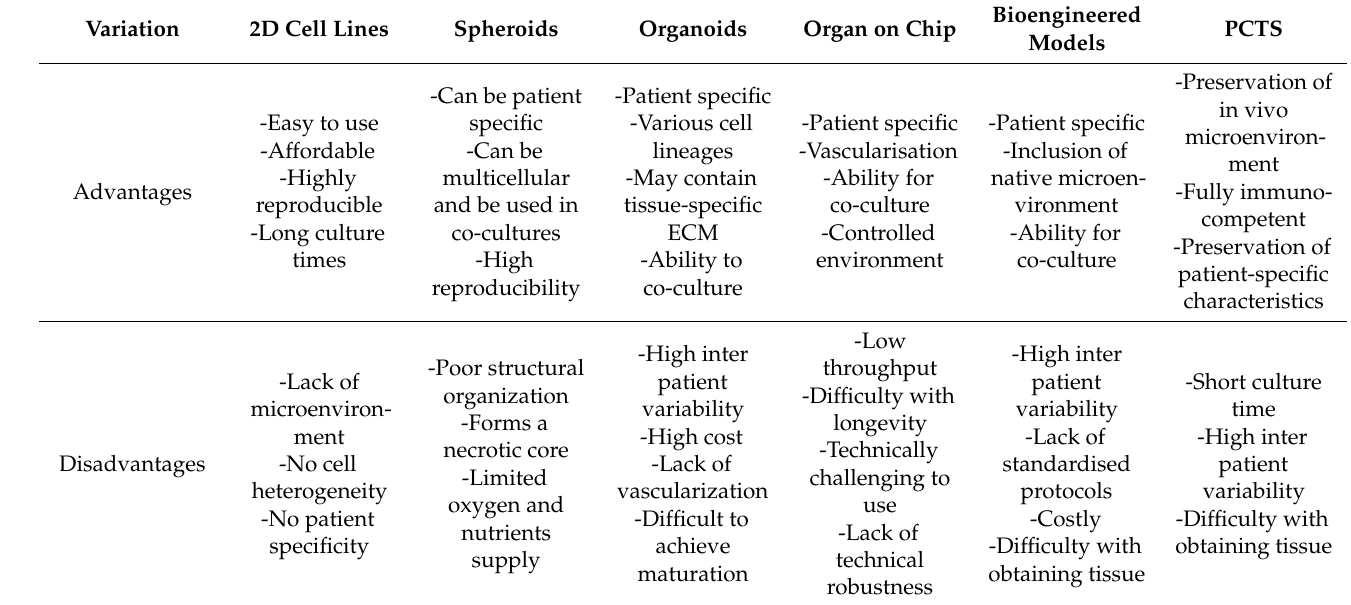
Table 2. Comparison of disease